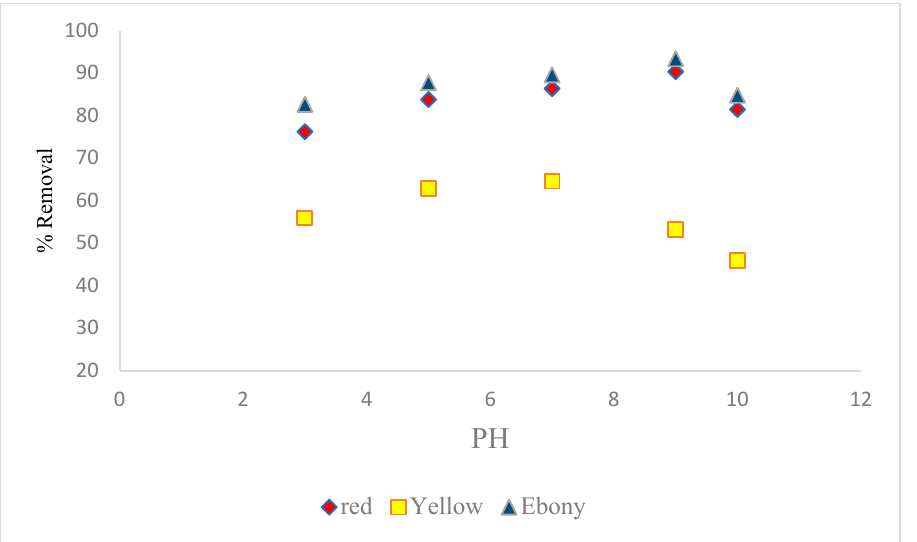
Figure 7. Effect of pH on the adsorption of hair dyes (red, yellow, and ebony) onto COZ; [dosage = 0.07 g R, 0.06 g Y, & 0.05 E, C i = 50 mg·L − 1 , contact time = 120 mint. For R and E, 150 mint. For Y, T = 25 ± 1 °C, speed = 150 rpm].